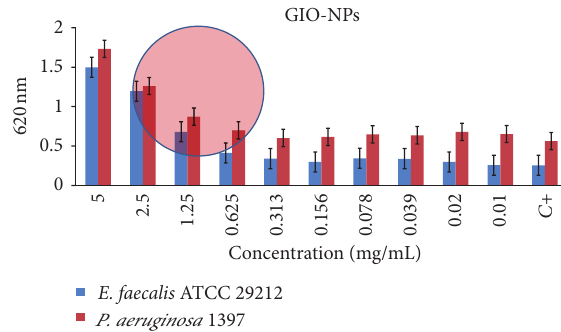
F 4: e quantitative assay of the MIC of the GIO-NPs on different microbial strains� quanti�ed by the pointed area indicates the direct correlation between the tested concentration and the bacterial growth stimulatory effect).